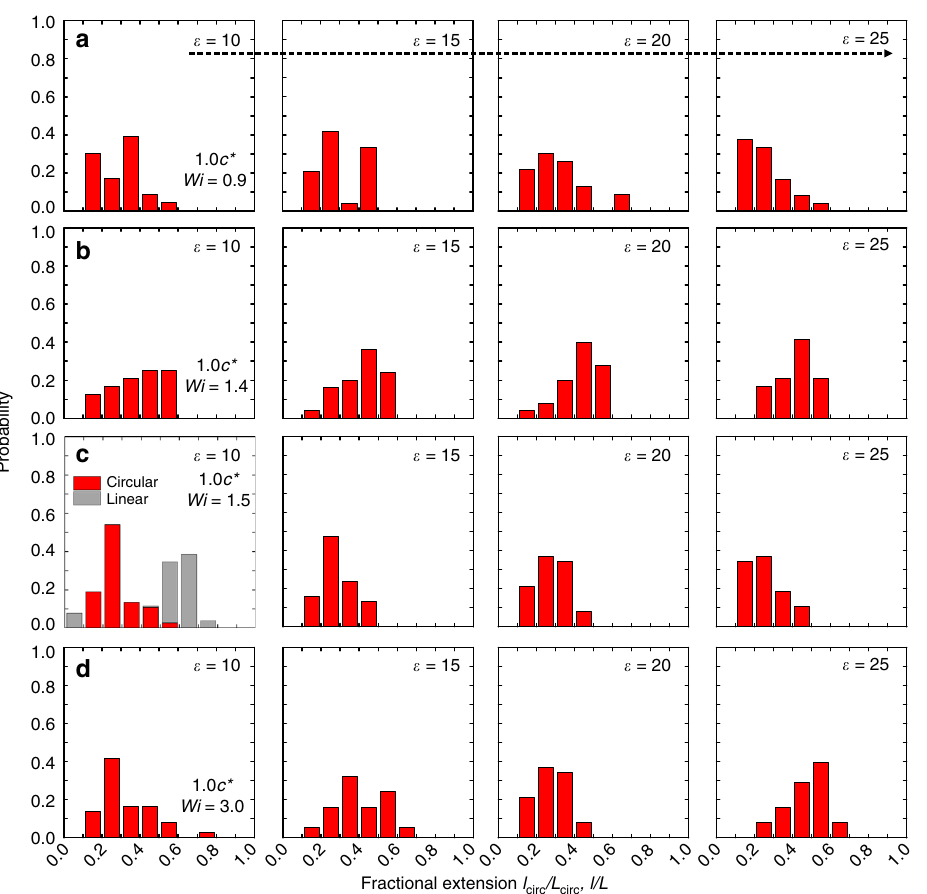
Fig. 5 Probability distribution of ring polymer extension. Experimental data show ring polymers (red bars) in background solutions of semidilute linear polymers at concentrations of 0.1 c * and 1.0 c * and accumulated fl uid strains of ϵ = 10, ϵ = 15, ϵ = 20, ϵ = 25. Molecular ensembles consist of a n = 24, b n = 25, c n = 38, and d n = 38 molecules. Data for 1.0 c * linear polymers (gray bars) are from Hsiao et al. 33 . Source data are provided as a Source Data fi